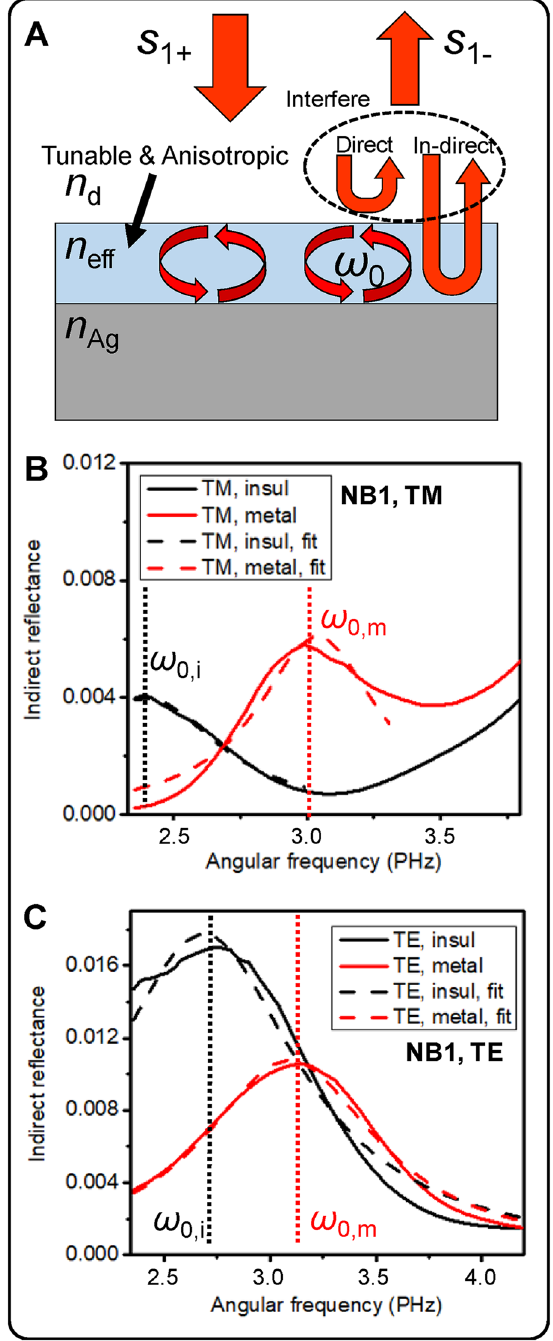
Figure 5: Fano-like resonance modeling. (A) Schematic illustration of the modeling of the dynamic dual resonances as Fano-like interferences between direct and in-direct reflectionwaves.(B,C)IndirectreflectancespectraoftheNB1metafilm when f Ag is 0.17 neglecting tapering walls and their Lorentzian fi tting results. The Indirect re fl ectance spectra and their fi tting results for (B) TM and (C) TE polarizations, respectively. The legends account for polarization direction and phase of VO 2 . The dashed lines in (B) and (C) are the results of Lorentzian fi tting near